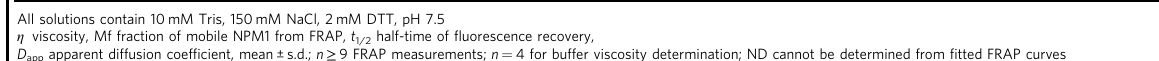
All solutions contain 10mM Tris, 150mM NaCl, 2mM DTT, pH 7.5 η viscosity, Mf fraction of mobile NPM1 from FRAP, t 1/2 half-time of fl uorescence recovery,